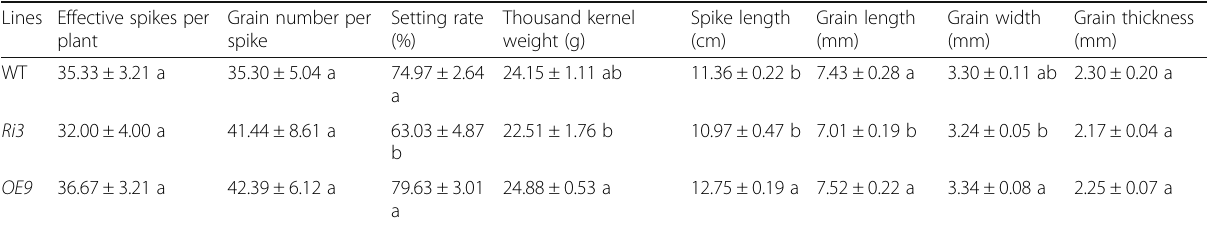
All grains measured after harvest and drying for 3days. Values are means±SEM, n =5. Significant differences ( P <0.05) are denoted by different lowercase